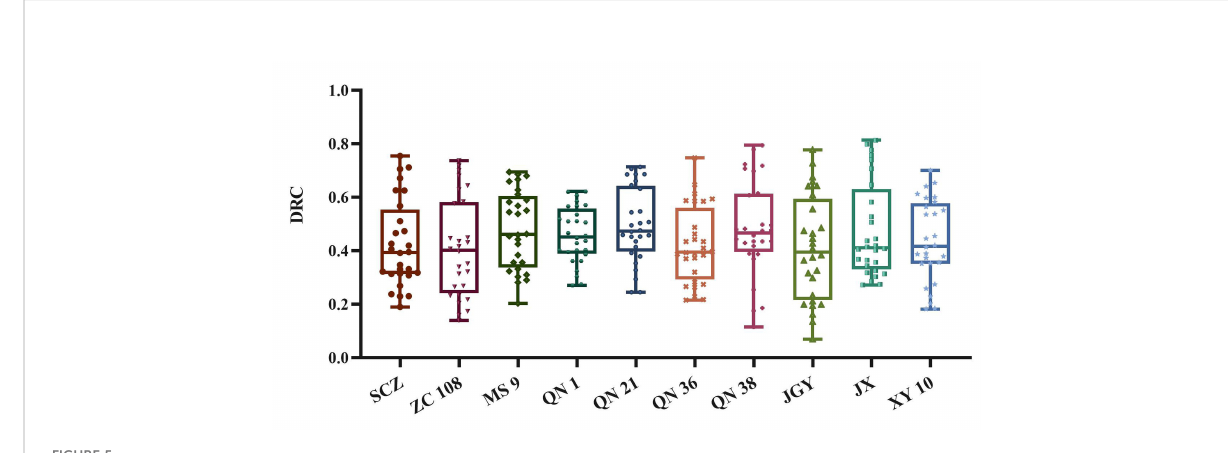
FIGURE 5 Statistical analysis results and distribution of DTC of different tea germplasm resources.